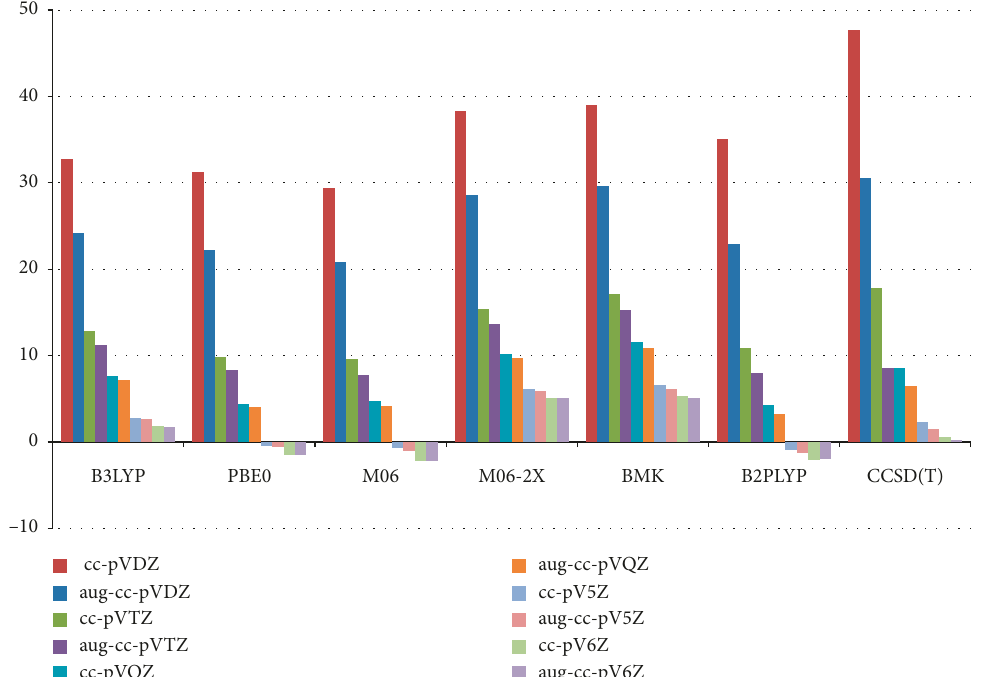
Figure 14: Unsigned error (with respect to the experimental value) in the enthalpy of formation of OClO at 298.15 K (in kcal/mol) as compared to the CCSD(T) calculations with the cc and aug-cc basis sets.